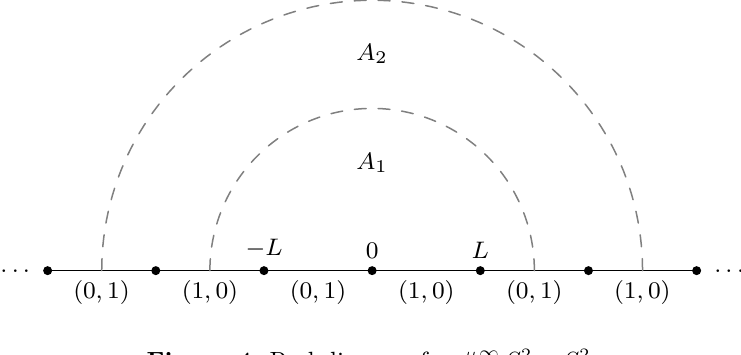
Figure 4 . Rod diagram for # ∞ S 2 × S 2